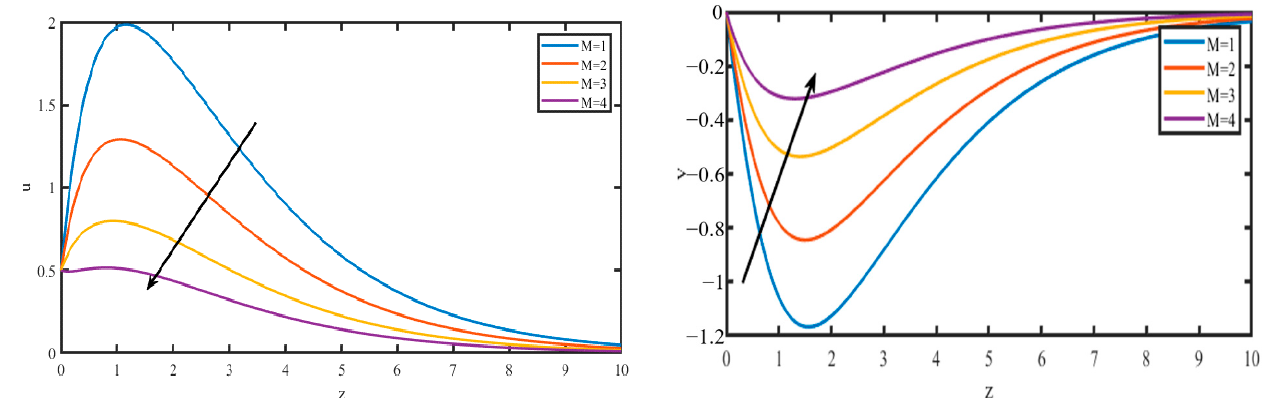
Figure 2. The velocity patterns for u and v plotted vs. M, with k = 0.50, R = 1.0, Gr = 5.0, S = 1.0, Gm = 3.0, m = 0.20, Pr = 0.710, H = 1.0, Sc = 0.220, Kc = 1.0, n = 0.50, t = 0.50, So = 0.50, F = 1.0.